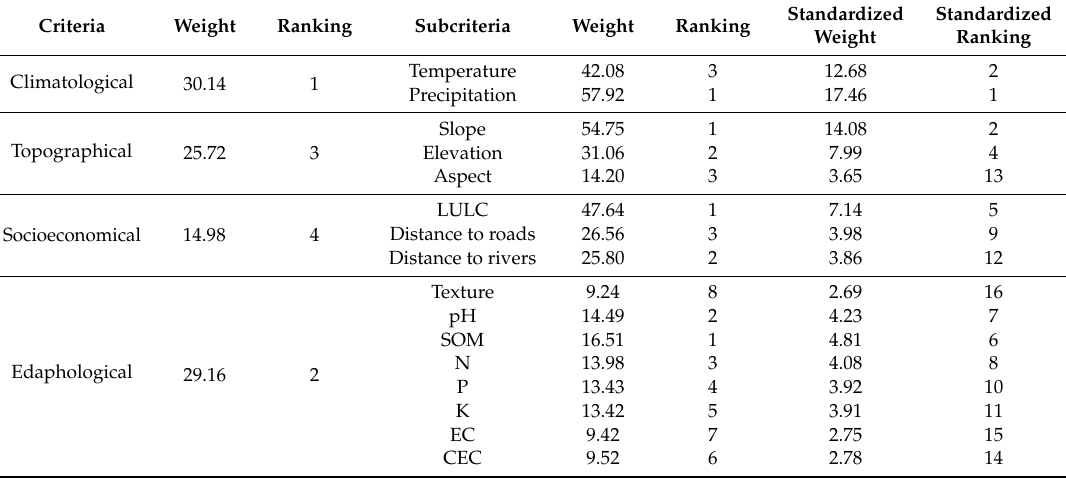
Table 7. Consistency Ratio (CR) of Pairwise Comparison Matrix (PCM). Climatological Ratio Criteria Subcriteria n RI